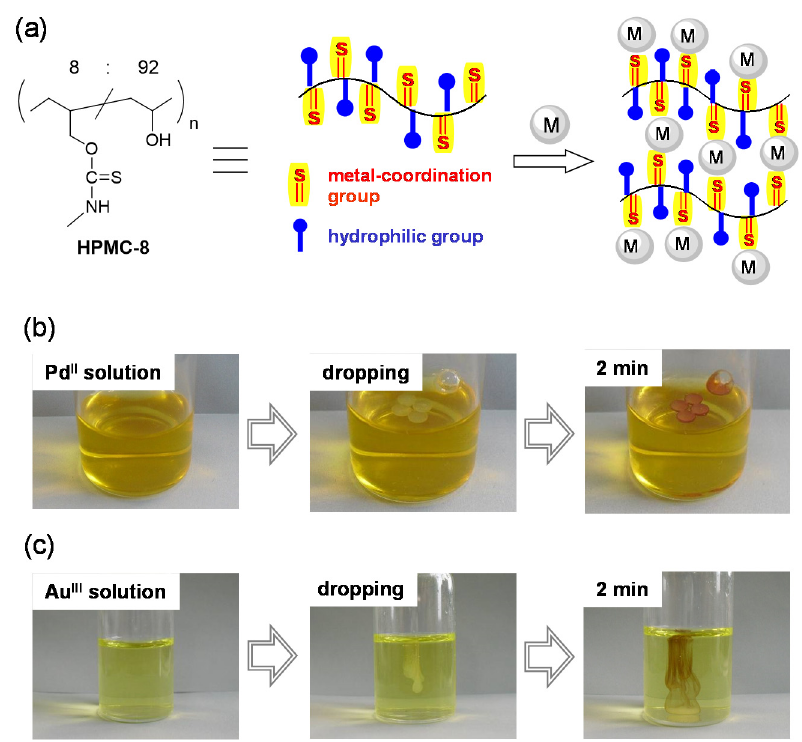
Figure 1. ( a ) Mechanism for gelation of HPMC ― 8 with metal ions. ( b ) Gelation behavior of HPMC ― 8 and Pd II ions. ( c ) Gelation behavior of HPMC ― 8 and Au III ions.